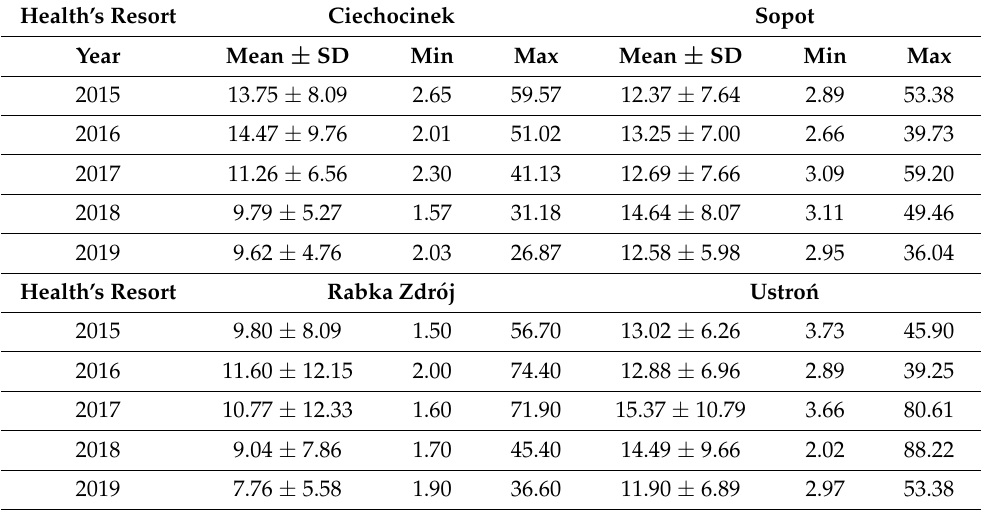
Table 4. Average annual values of NO 2 in the studied health resorts in 2015–2019. Health’s Resort Ciechocinek